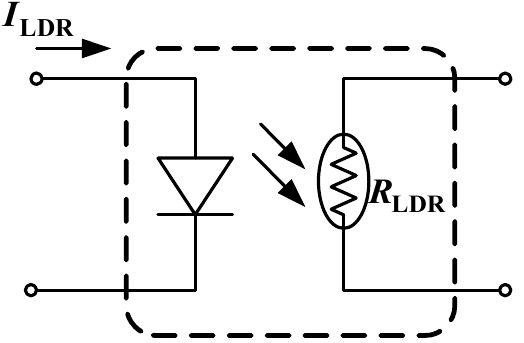
Figure 6. LED controlled light dependent resistor.